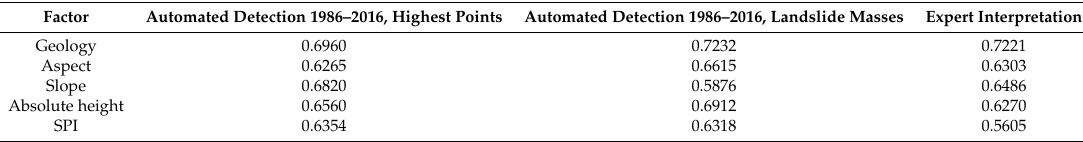
Table 3. Discrimination ability of predisposing factors: area under the receiver operating characteristic (AUROC) curve values of susceptibility models based on a single factor.